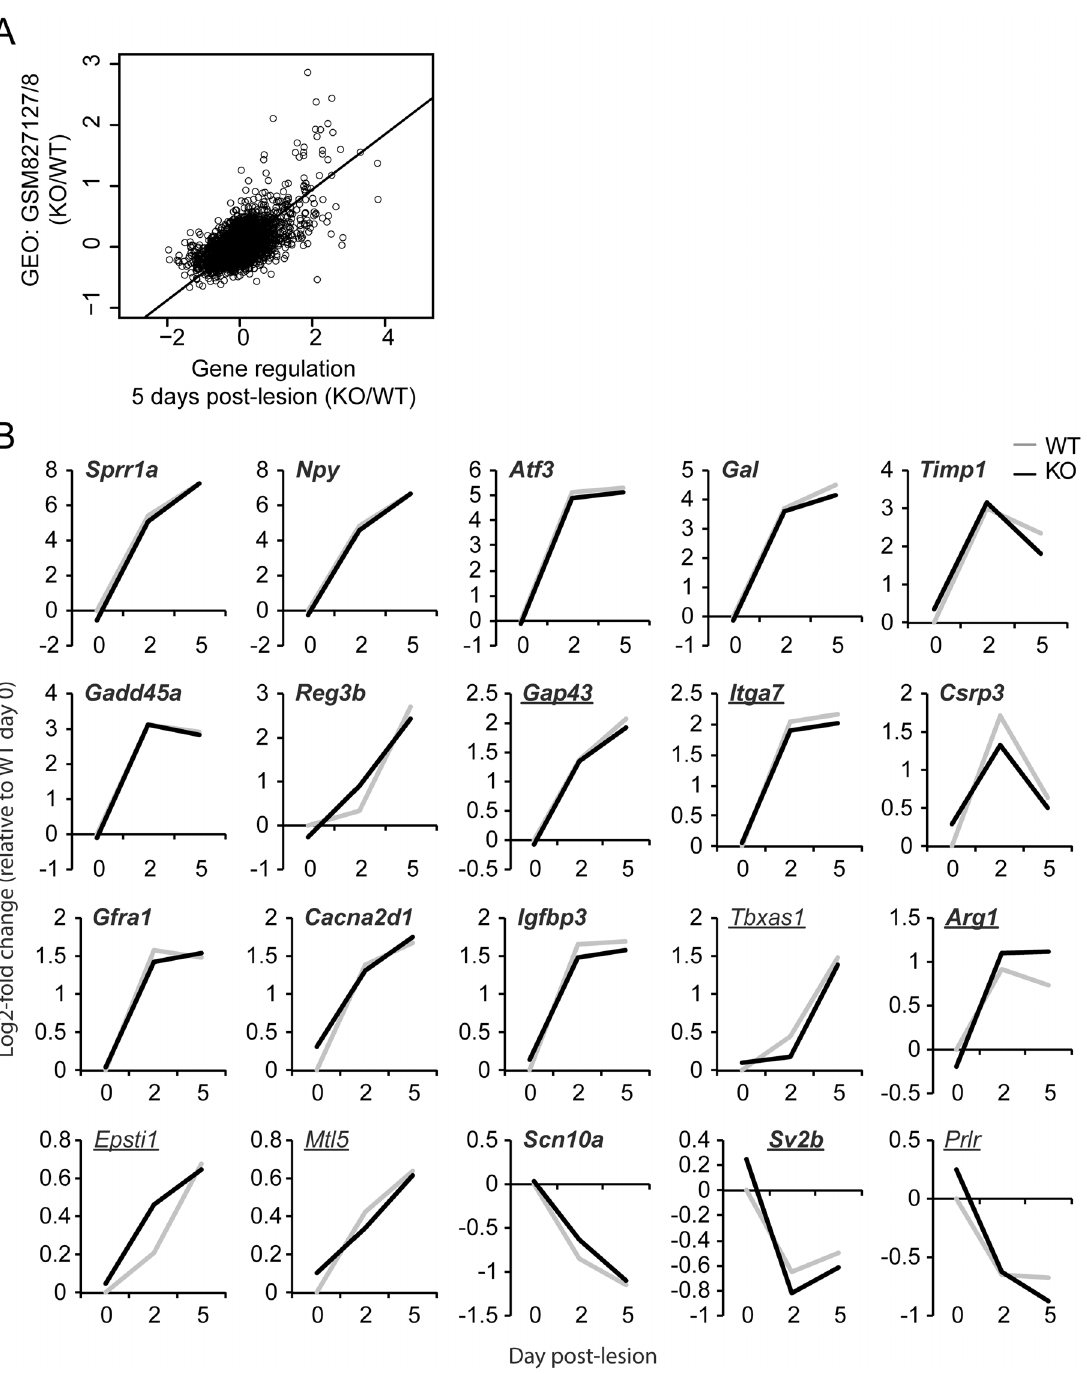
Fig 5. NFIL3 deletion does not alter the expression of regeneration-associated genes. (a) Gene expression was profiled in Nfil3 KO mice and wildtype controls at 2 days and at 5 days post-lesion, relative to non-injured control DRGs. Gene regulation values in wildtype animals at post-lesion day 5 show a highly significant correlation (r = 0.48, p < 2.2x10 -16 ) with previously published data [31] describing injury-induced gene expression changes in mouse DRGs at the same time point (GEO datasets GSM827127/8). (b) The expression of well-established regeneration-associated genes and/or NFIL3 target genes is not affected in Nfil3 KO animals compared with wildtype controls. Of the 20 genes indicated here, 16 are in the core set of regeneration-associated genes identified in three or more independent microarray studies (bold print) [32], and 8 are experimentally validated NFIL3 target genes (underlined) [11, 12]. No significant differences were observed between expression profiles of Nfil3 KO animals and wildtype